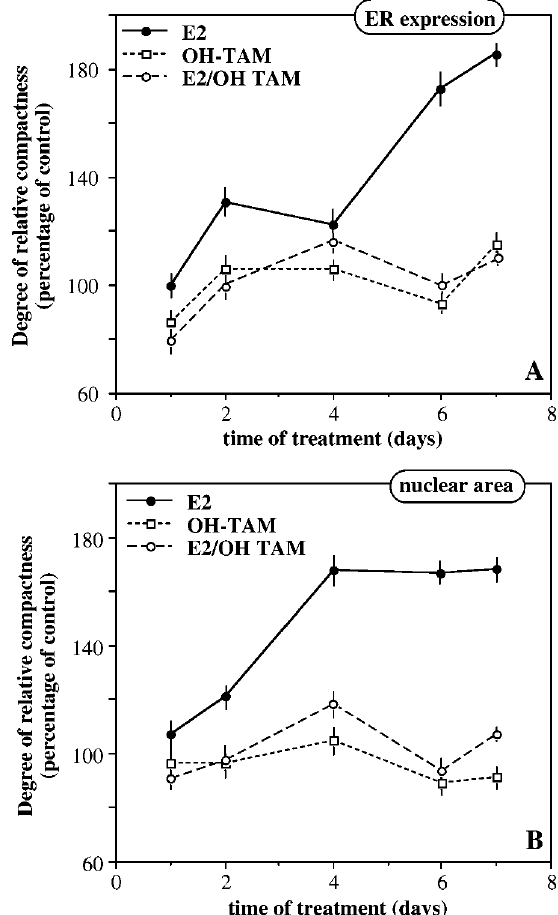
Fig. 7. Degree of relative compactness of MCF-7 cells as a function of nuclear estrogen receptor content (A) and nuclear area (B). Data are the mean (cid:6) SD from four independent